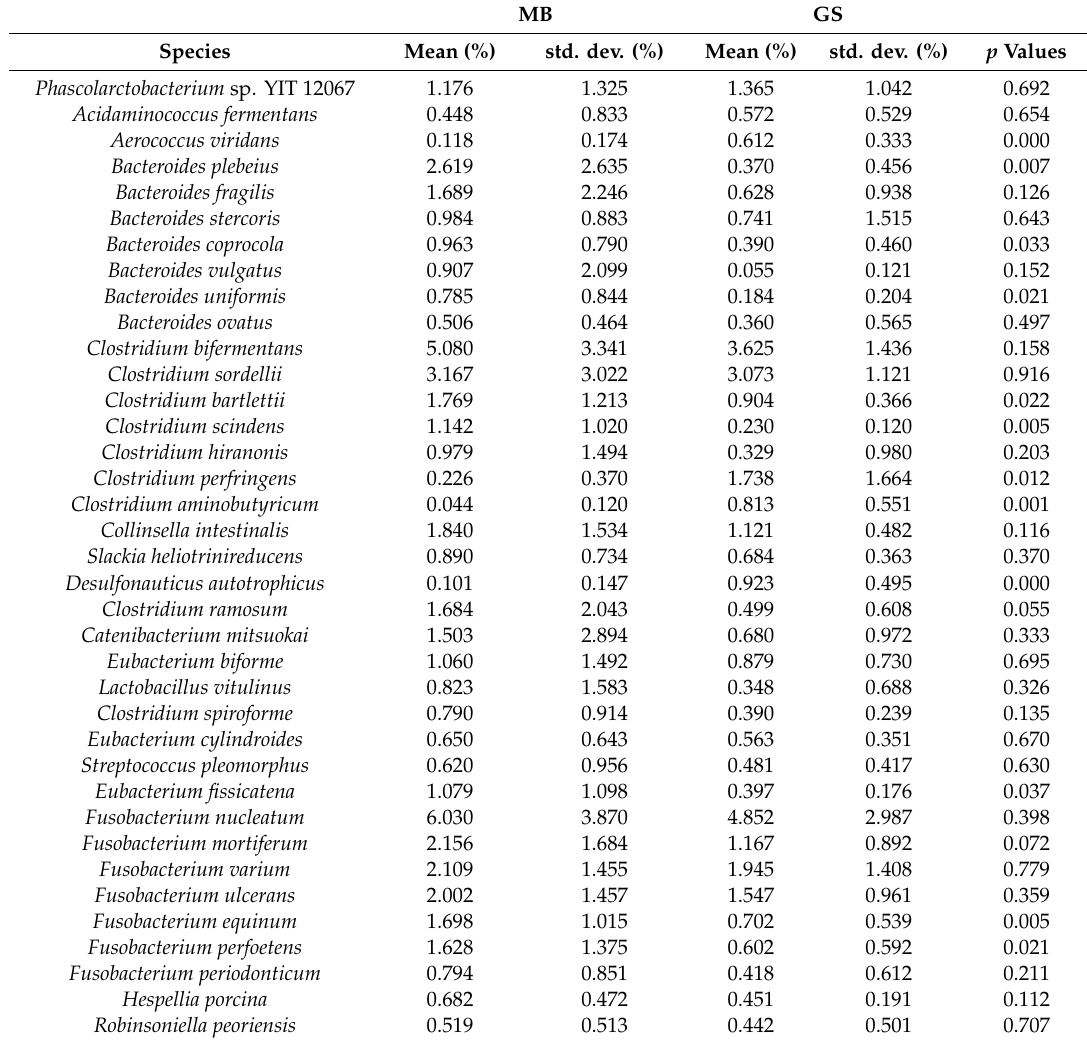
Table 6. Mean relative frequency of abundance (%) and corresponding standard deviation (SD) (%) of the species identified in the caeca of mixed breeds (MB) and German Shepherd (GS) dogs. The species indicated are those showing a mean relative frequency of abundance ≥ 0.5% in at least one group. p values in bold are those who are significantly di ff